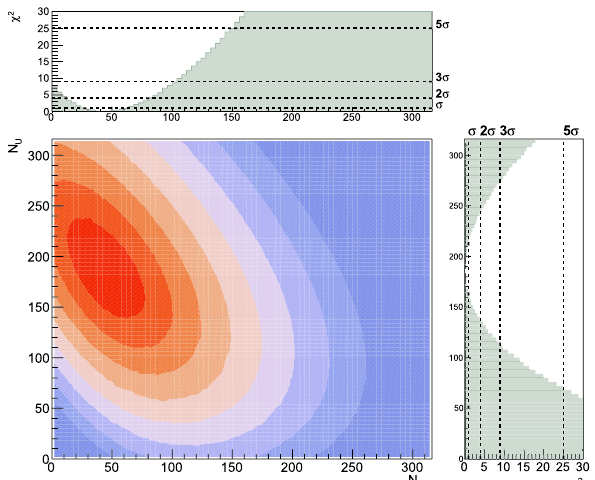
Fig. 12 2-D confidence level of the number of Th versus U antineutri- nos detected after one year of data taking, assuming systematic uncer- tainties from Table 10, and estimated with 1000 toy experiments. The confidence level are drawn for [ 1 σ, 8 σ ] . The individual projections for each contribution at the best-fit value are also shown with the statistical significance as dashed lines